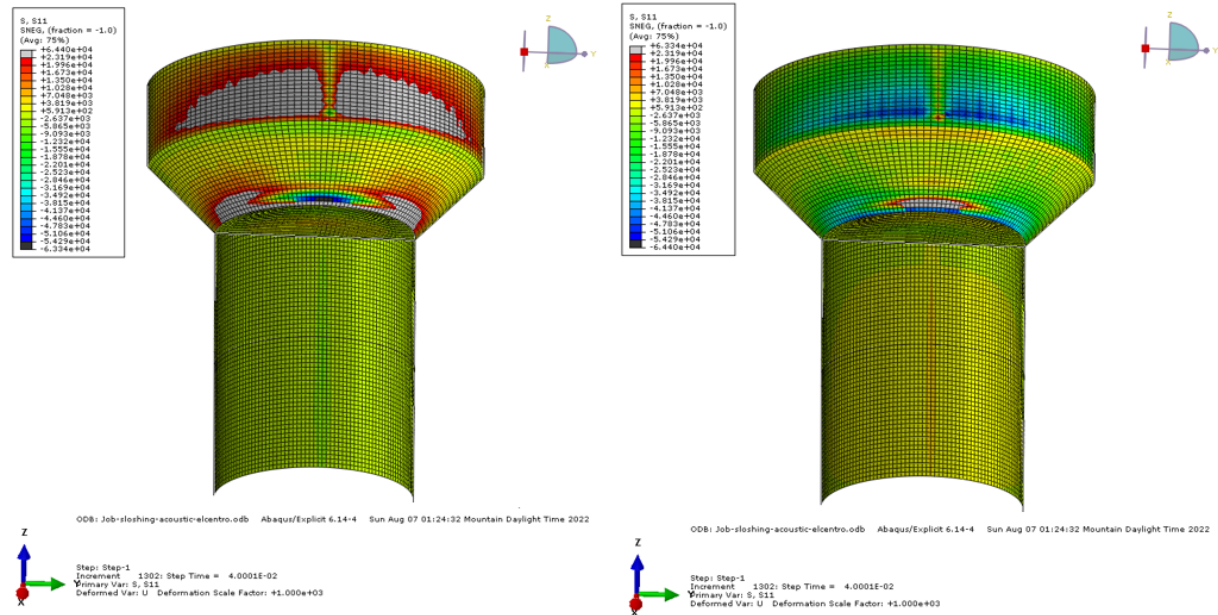
Figure 18. Example of the effect of the overturning moment resulting from sloshing on the distribution of maximum stress.